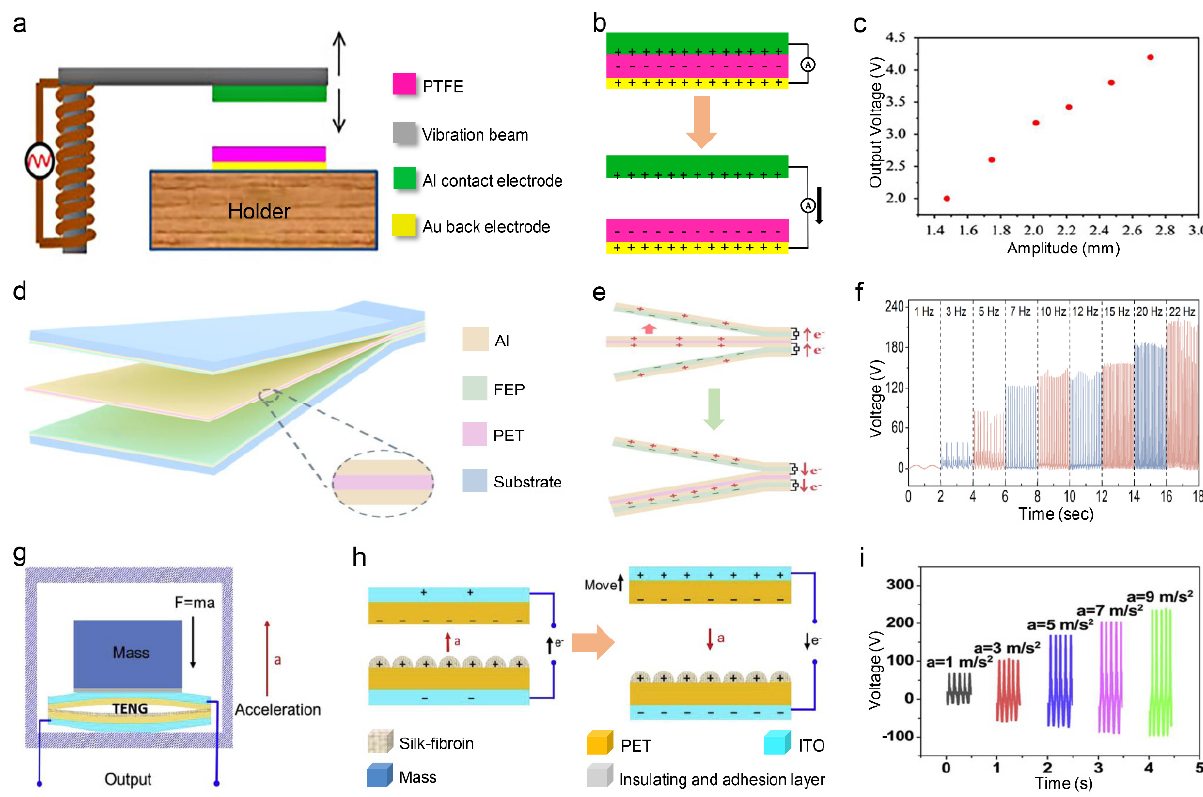
Figure 4. The elastomer-based vibration sensor. ( a ) Schematic structure of the B-TENG. ( b ) Working mechanism of the B-TENG. ( c ) Output voltage curve under different vibration amplitude. Reproduced with permission [105]. Copyright 2014, Elsevier. ( d ) Schematic structure and materials design of the C-TENG. ( e ) Working principle of the C-TENG. ( f ) Output voltage of the C-TENG when the frequency changes from 1 to 22 Hz. Reproduced with permission [121]. Copyright 2022, American Chemical Society. ( g ) Structure design of the self-powered acceleration sensor. ( h ) Working mechanism of the self-powered acceleration sensor. ( i ) Output voltage of the sensor when the acceleration changes from 1 to 9 m/s 2 . Reproduced with permission [106]. Copyright 2019,